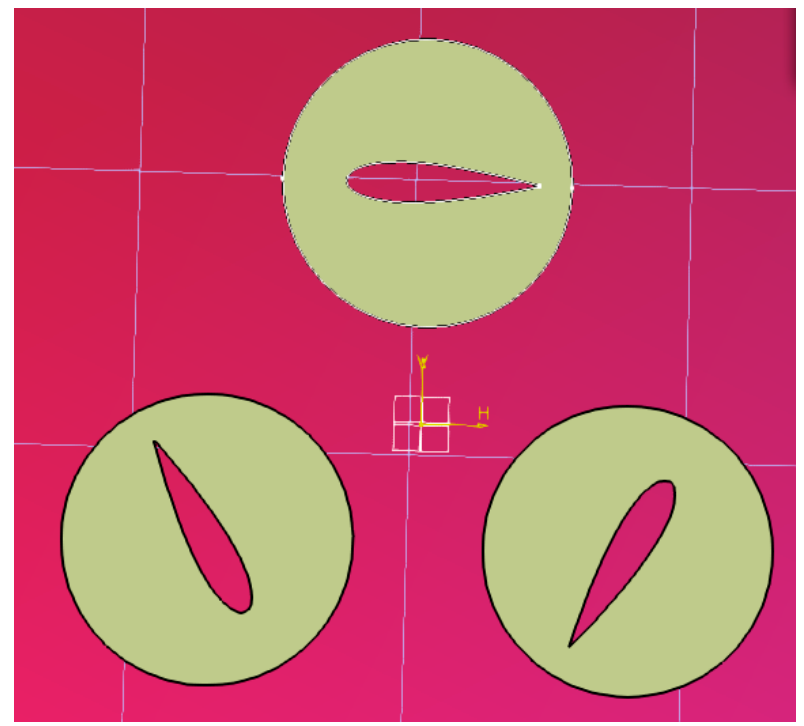
Figure 5. Sketch of the Darrieus rotor blades in CATIA.